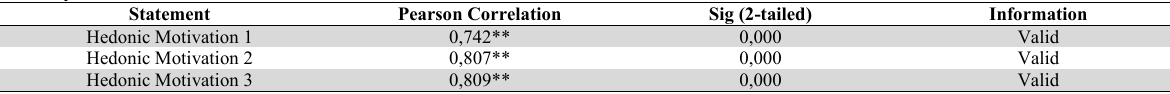
Validity Test Results for Hedonic Motivation